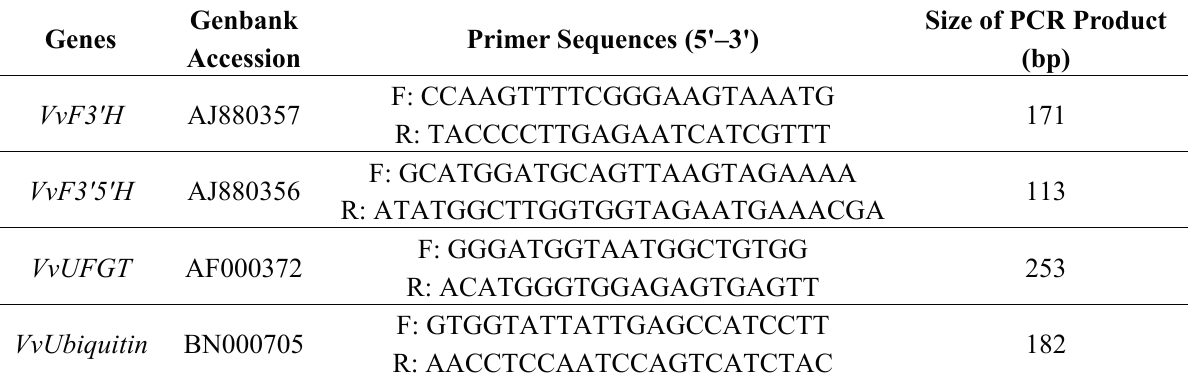
Table 2. The primers of genes used in the Real-Time PCR